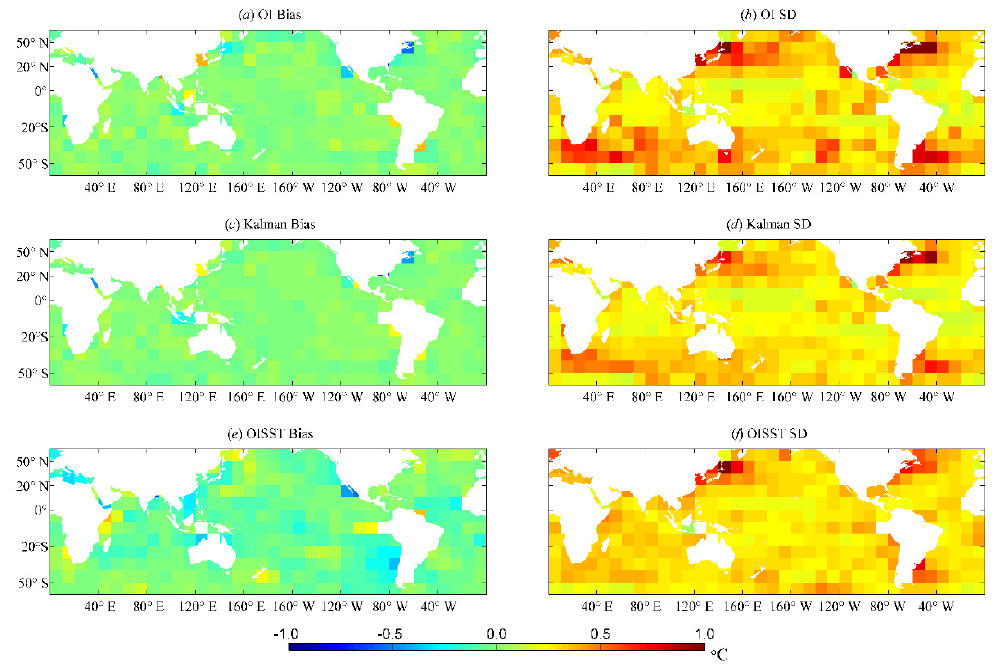
Figure 8. Comparison of the average bias (BIAS) and standard deviation (SD) from 2016 from ( a , b ) OI, ( c , d ) Kalman and ( e , f ) OISST results in global 10° × 10° grids.